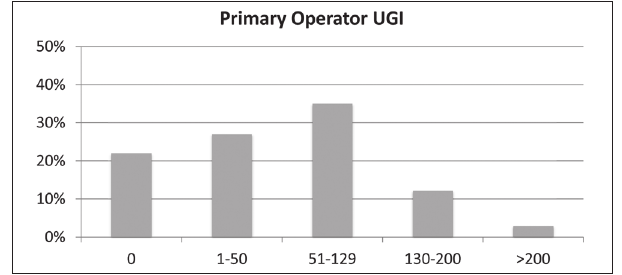
Figure 5) Volume of lower gastrointestinal (LGI) procedures performed by Canadian surgical residents across all years of training. Adapted with per- mission from the Canadian Association of General Surgeons Residency Committee